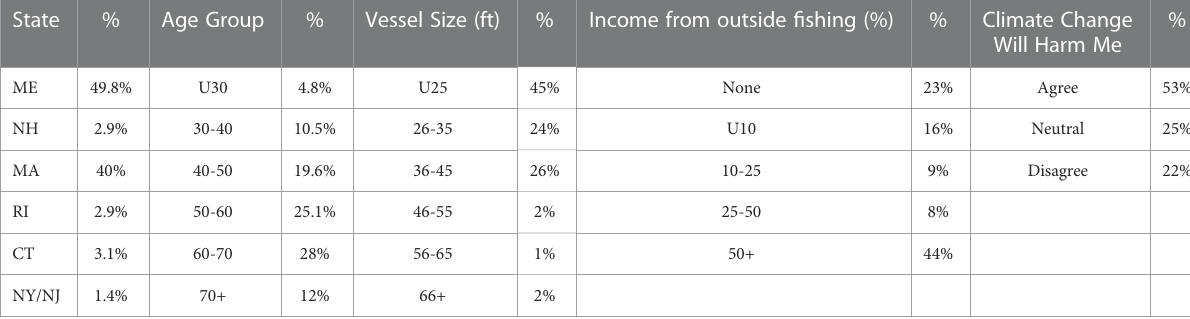
TABLE 1 Demographic summary and the perception of climate change of survey respondents.